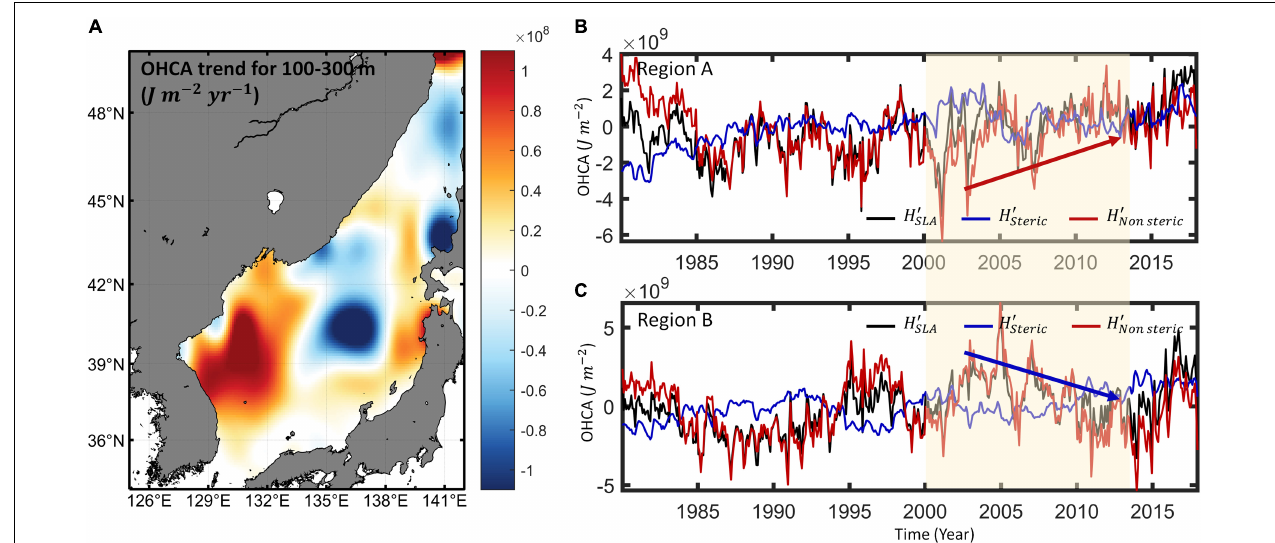
FIGURE 7 | (A) Spatial pattern of the ocean heat content (OHC) trend in the intermediate layer (100–300 m) during the SWS period. Time series of the OHC anomaly (OHCA) in (B) Region A and (C) Region B. Yellow rectangular shading in panels (B,C) represents the SWS periods. Red and blue arrows indicate the increasing and decreasing OHC trends, respectively. Black, blue, and red lines indicate H (cid:48) SLA , H (cid:48) Steric , and H (cid:48) Nonsteric , respectively.